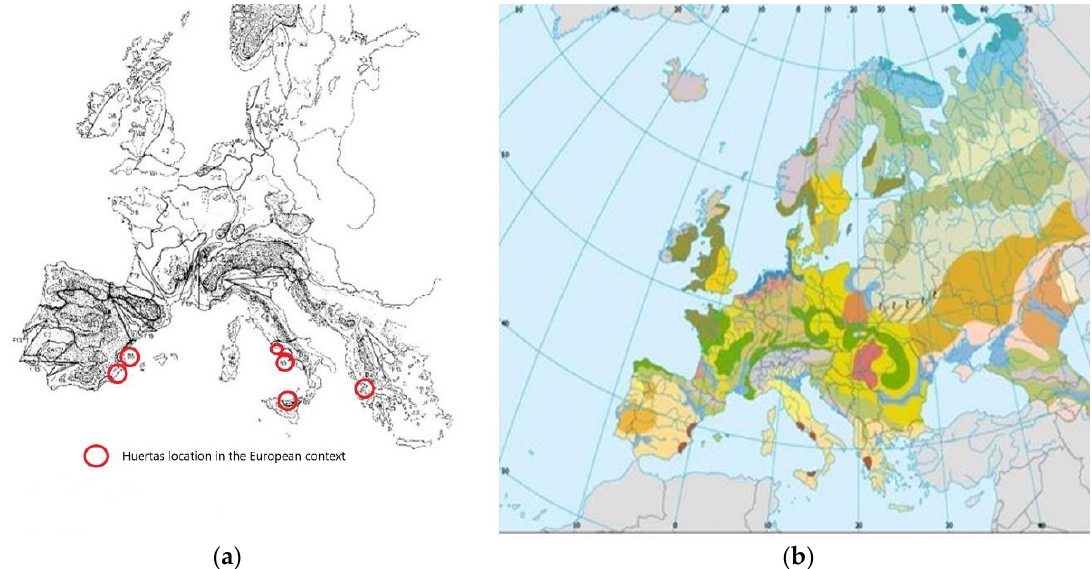
Figure 1. ( a ) Agricultural landscapes in Europe [1] (p.298); ( b ) Dobris Report map for European Landscapes, based on Meeus et al. map [2]. Note that Huerta locations are highlighted in dark-red shaded spots.